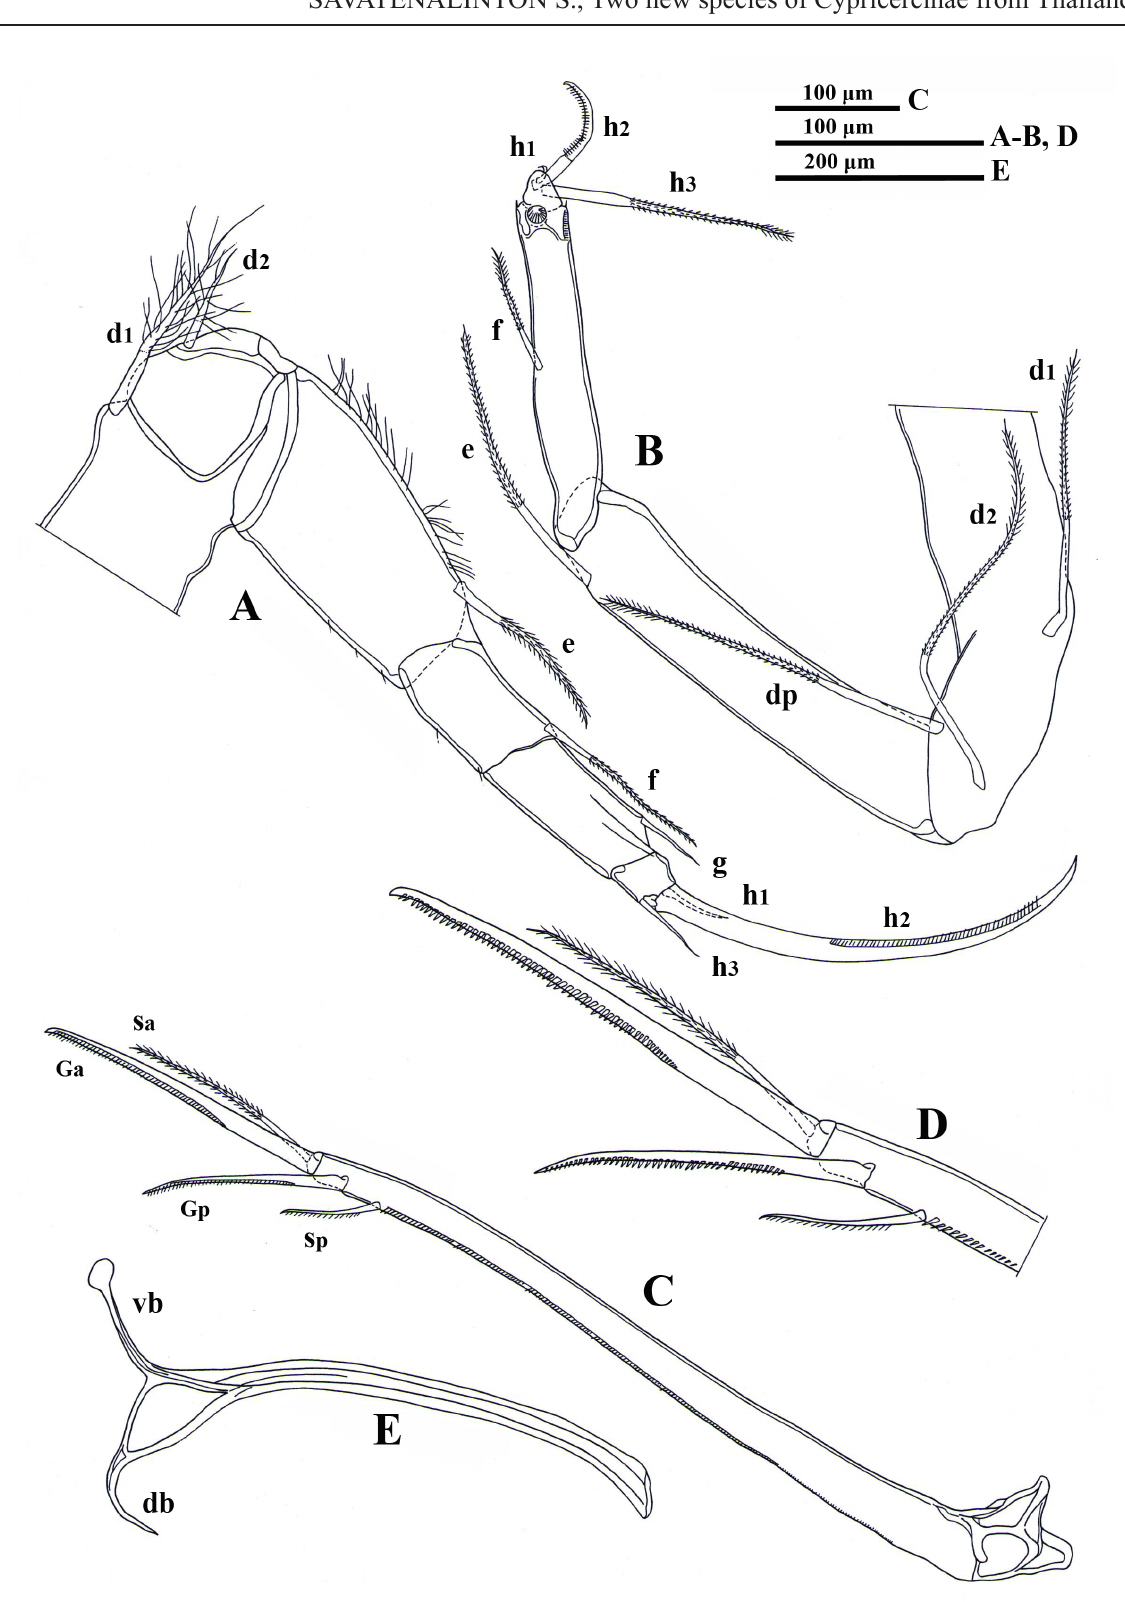
Fig. 10. Strandesia prachuapensis sp. nov. Holotype, ♀ (MSU-ZOC.303). A . T2. B . T3. C . CR. D . Distal end of CR. E . CR